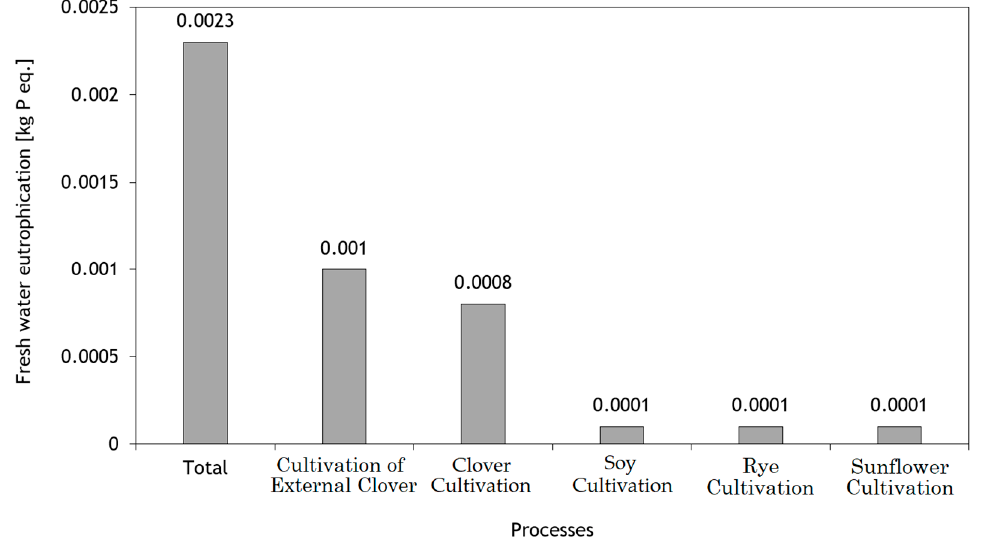
Figure 7. Freshwater eutrophication results associated with each sub-system of the production of 1 kg of cheese.